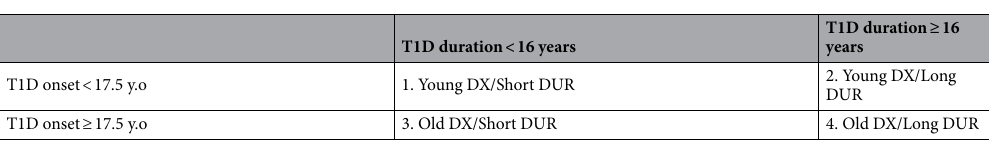
Figure 2. Venn diagram of miRs showing significant expression (Ct) differences in participants with diabetes with versus without detectable C-peptide, participants with and without diabetes with C-peptide levels below and above median. Arrows indicating the miRs abundance difference in comparison to the reference group ( : compared with undetectable for C-peptide status, and : compared with below median C-peptide levels in participants with and without diabetes